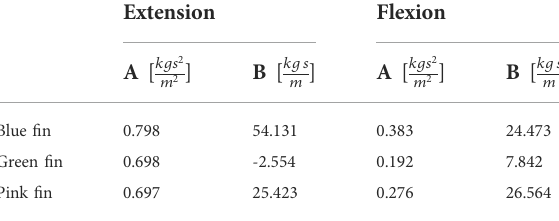
TABLE 1 Coef fi cients of the fi tted polynomials.